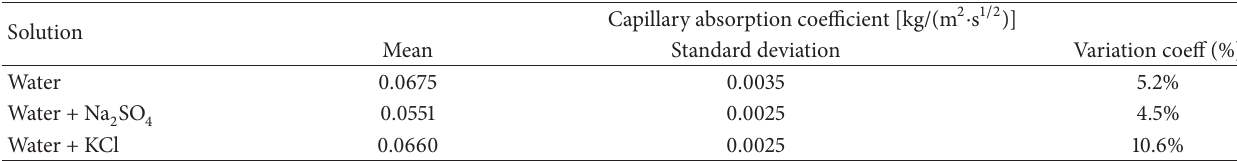
Figure 3: Illustration of some samples after several weeks of the 2 ∘ cycle tests: (a) monolithic specimens and (b) perfect contact interface. Table 2: Capillary absorption coefficient of monolithic red brick specimens partially immersed in pure water and saturated solutions of KCl and Na 2 SO 4